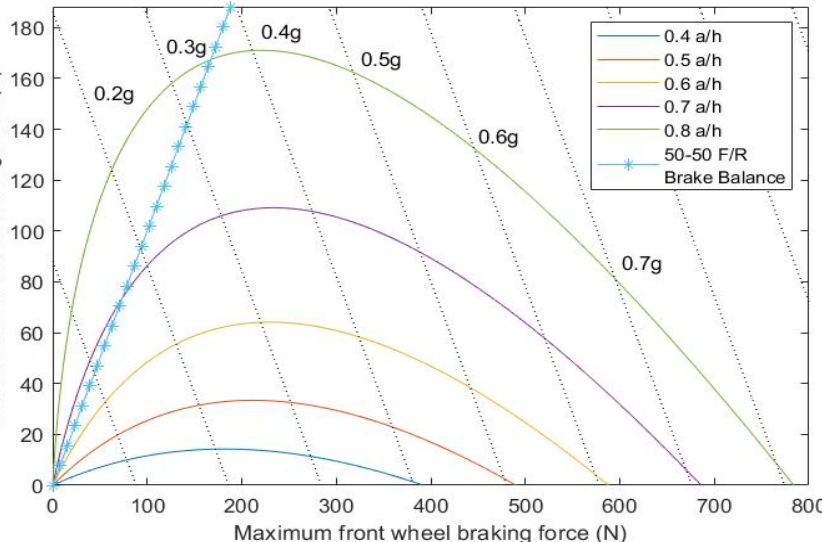
Figure 6. Maximum front and rear braking force profiles for the varying center of mass position ( a cm / h cm ) [8]. The blue line with asterisks shows the braking profile of the equal front and rear brake pressure. Dotted lines delineate the deceleration rate.